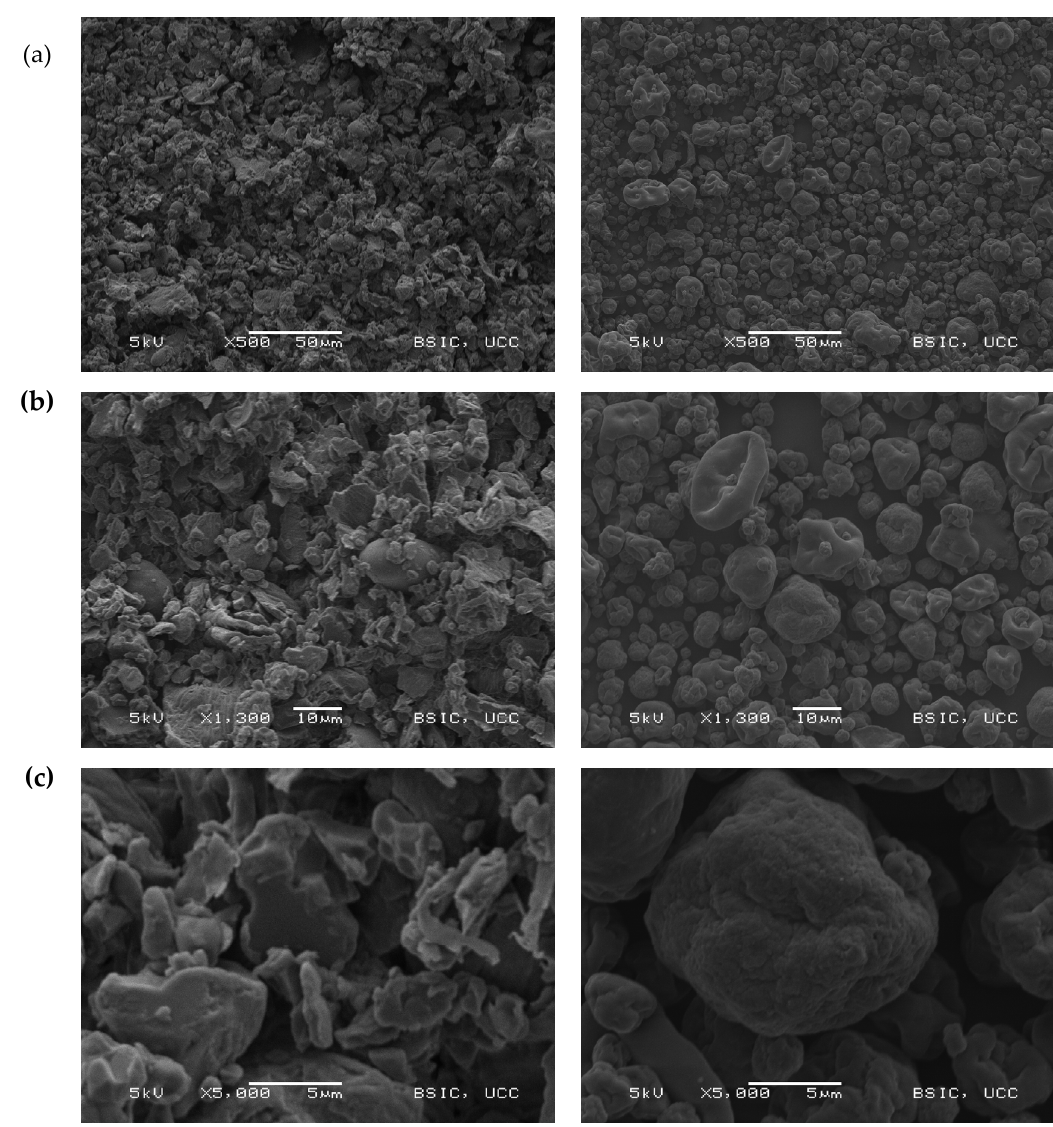
Figure 2. Representative scanning electron micrographs of FPR (left column) and FPI (right column). Magnifications shown are ( a ): 500×, ( b ): 1300× and ( c ): 5000×.